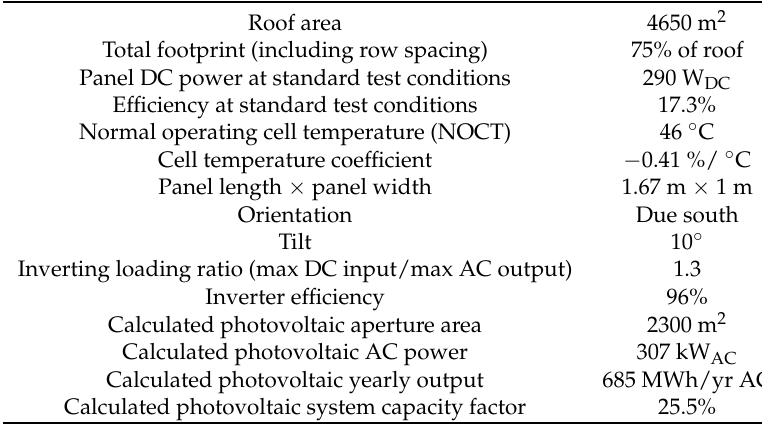
Table A3. Photovoltaic power generation